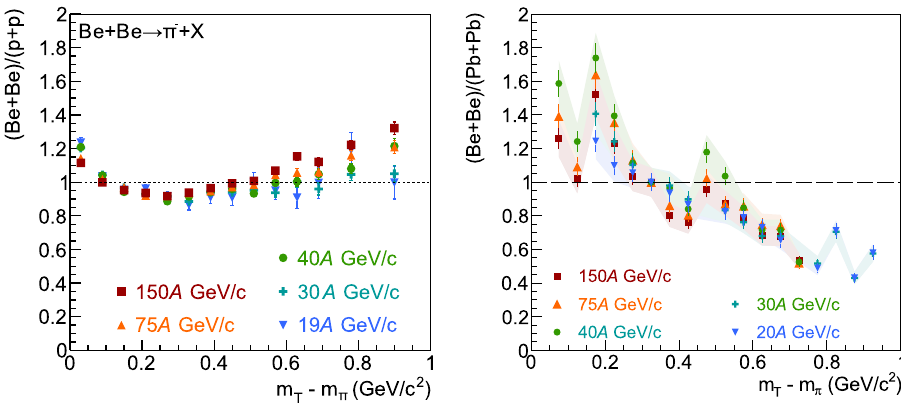
Fig. 14 Ratio of normalized transverse mass spectra: Be + Be/ p+p (left) and Be + Be/Pb + Pb (right) at the SPS